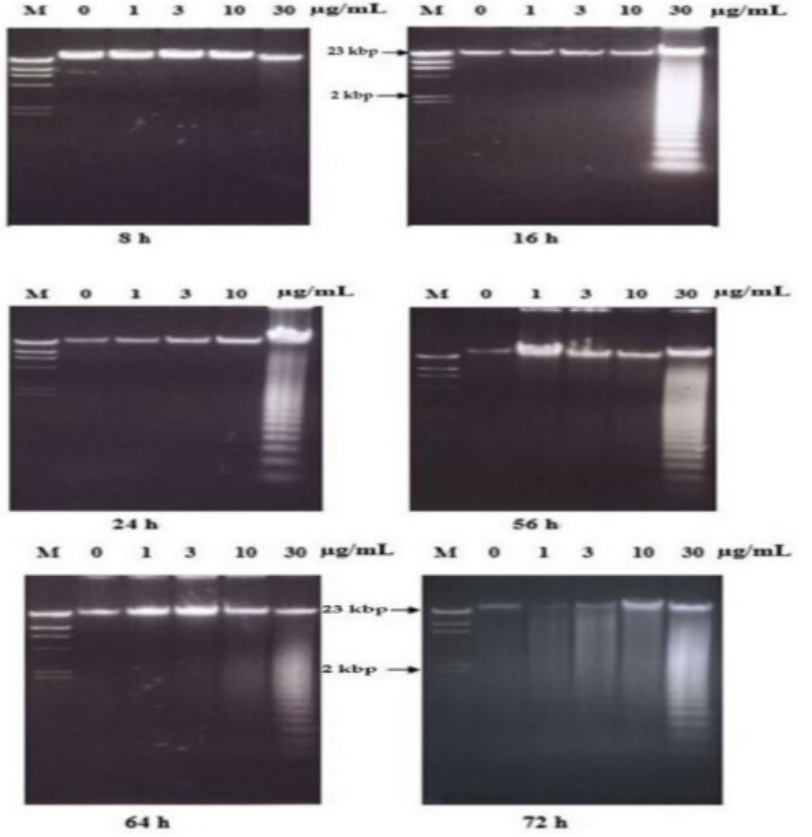
Figure 8. Effects of different concentrations of damnacanthal at different hours on DNA fragmentation in CEM-SS cells. Lane M: Marker ( Hind III digest of lambda DNA).